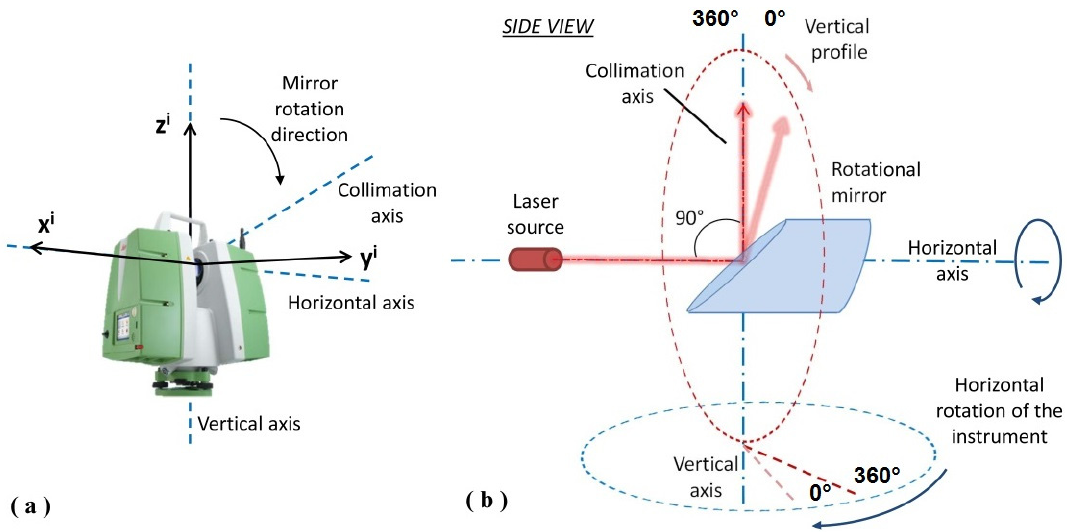
Figure 1. ( a ) Local Cartesian coordinate system of a terrestrial laser scanner (TLS), with respect to the main instrument axes; ( b ) perfect panoramic TLS geometry [23].